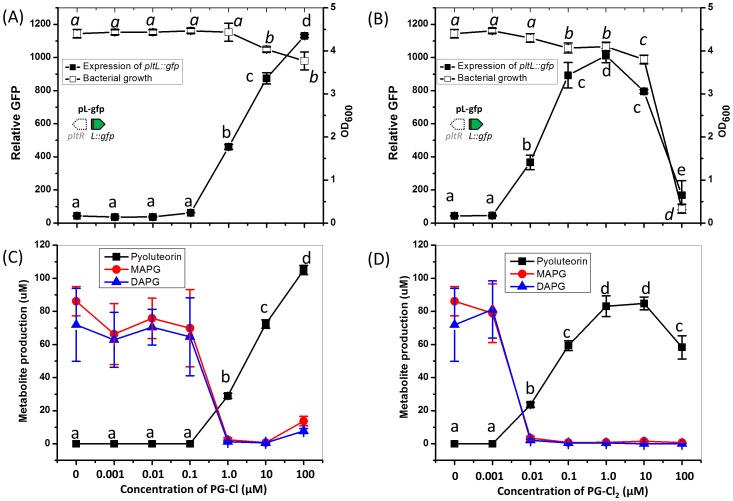
Influence of PG-Cl (left) and PG-Cl2 (right) on expression of pltL::gfp (A, B) and production of pyoluteorin (C, D) in the ΔpltM mutant of P. protegens Pf-5.The ΔpltM mutant was cultured in NBGly amended with increasing concentrations of PG-Cl and PG-Cl2. To test the regulatory effects of PG-Cl and PG-Cl2 on expression of pyoluteorin biosynthetic genes, GFP activity was determined from the ΔpltM mutant containing pL-gfp 20 hr after inoculation (A, B). The OD600 value of bacterial cultures (24 hr after inoculation) was measured to show the influence of PG-Cl and PG-Cl2 on the bacterial growth (A, B). The bacterial cultures were extracted 24 hr after inoculation and production of pyoluteorin, MAPG and DAPG were quantified (C, D). Letters above the symbols indicate treatments significantly different from one another, as determined by ANOVA analysis (p<0.05). Data are means of at least three biological replicates from a representative experiment repeated twice with similar results, and error bars represent the standard deviation of the mean.DOI:
http://dx.doi.org/10.7554/eLife.22835.01810.7554/eLife.22835.019Figure 6—source data 1.Expression of pltL::gfp and production of pyoluteorin by the ΔpltM mutant of Pf-5 in response to chlorinated phloroglucinols.The production of MAPG and DAPG is also shown.